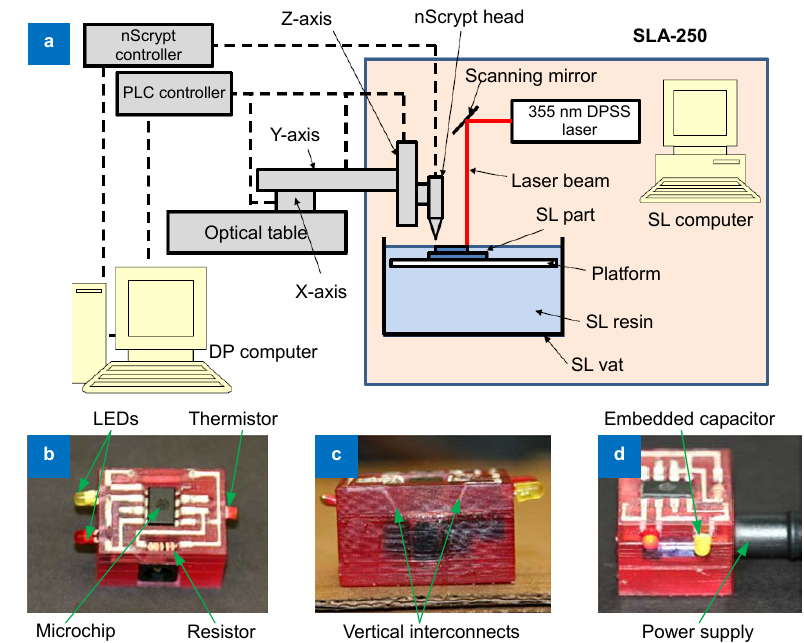
Fig. 6 | ( a ) Schematic of the hybrid SL/DP system. ( b ~ d ) Fabricated 3D 555 timer circuits packaged within SL substrates 24 .